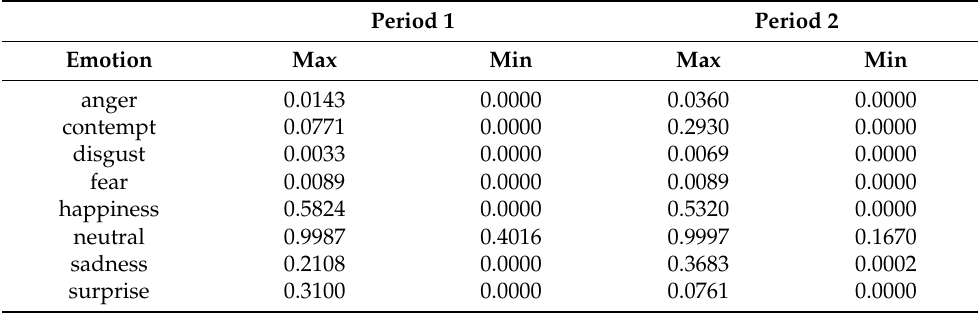
tions. Table 3. Maximum and minimum mean of the emotion